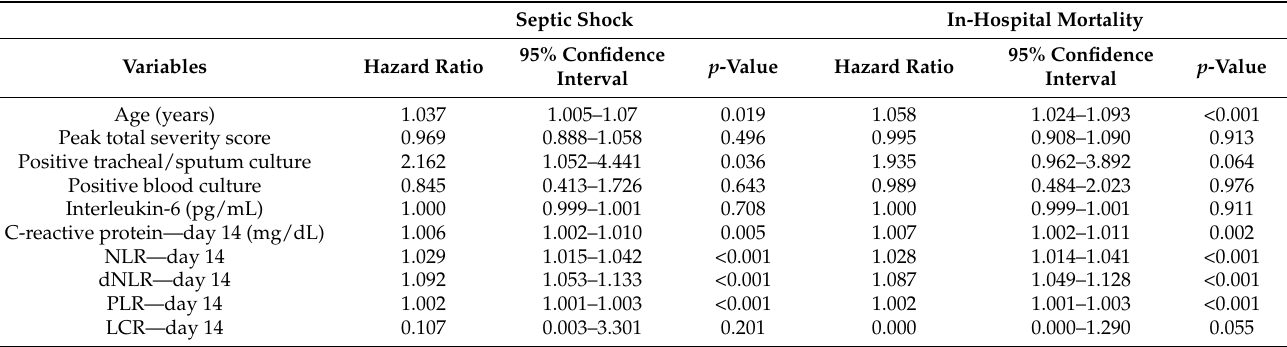
Table 2. Univariate analysis using Cox-proportional hazards model for the risk of septic shock and in-hospital